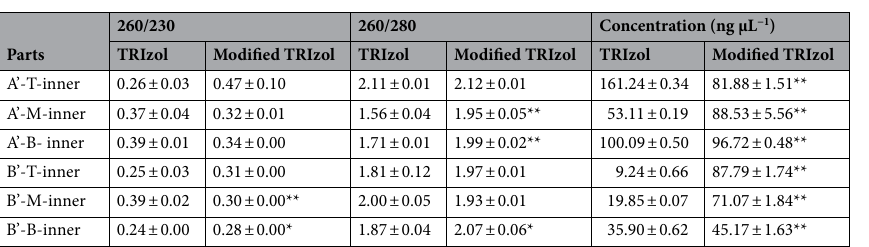
Table 4. Average purity and yield of total RNA extracted from inner scales of other Lilium species using the two TRIzol methods. A’: Lilium lancifolium Thunb.; B’: Lilium brownii var. viridulum Baker; T: The top part of the detected scales; M: The middle part of the detected scales; B: The basal part of the detected scales. Values with asterisks represent significant difference between the two TRIzol methods by using T test in SPSS 24.0 software (* P < 0.05 and ** P <